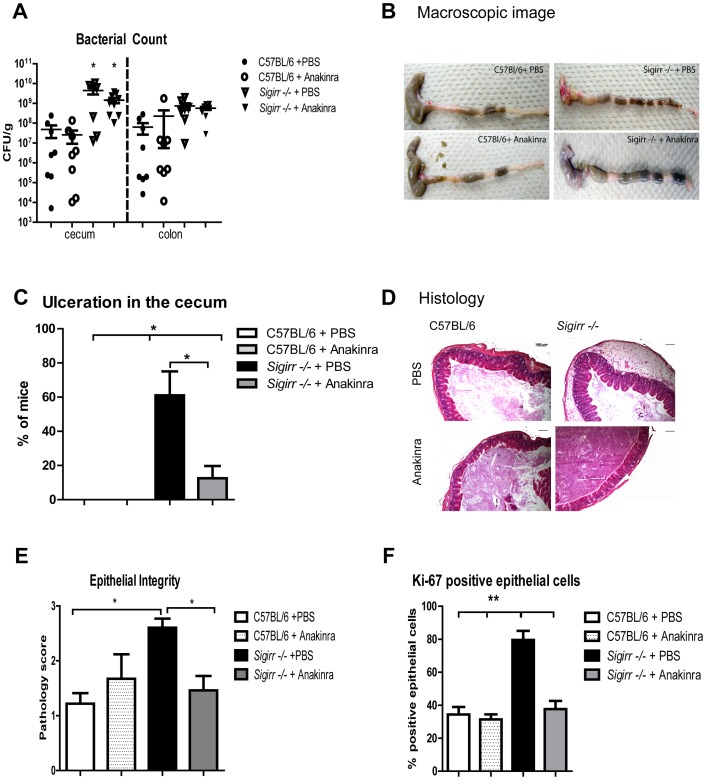
The exaggerated colitis seen in the Sigirr −/− mice is attenuated by treatment with the IL-1R antagonist anakinra.WT and Sigirr −/− mice were intra-peritoneally injected twice with anakinra (1 mg/mouse) each day for 6 days, or with PBS during C. rodentium infection. Anakinra treatment did not impact on pathogen burdens in infected mice (A) however treatment with anakinra ameliorated macroscopic ulceration in infected Sigirr −/− mice (B–C) along with reducing edema and improving epithelial integrity (D–E). Immunostaining for the proliferation marker Ki-67 demonstrated treatment with anakinra reduced the elevated IEC proliferation observed in Sigirr −/− mice (F). Pathogen counts represent mucosal associated bacteria. Results are pooled from 2 independent infections each with n = 3–4 per group. Error bars = SEM, (Student t test (Figure A, C), *P<0.05, **P<0.01). Images were taken at 200× magnification.